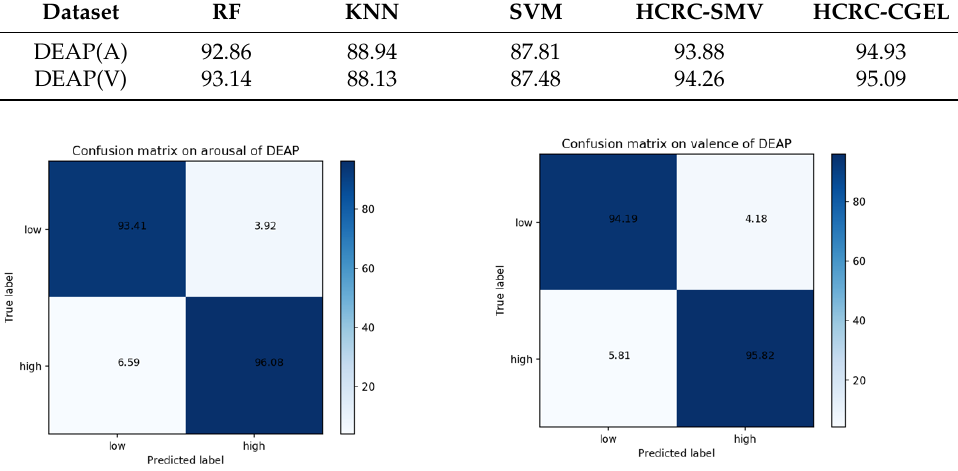
Figure 7. The confusion matrix in the arousal and valence of DEAP databases. Table 3. Mean accuracy in arousal and valence of DEAP Table 2. Performance (%) of each method on DEAP database.